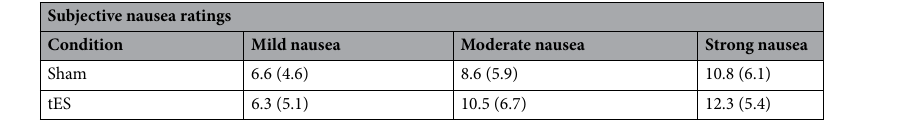
Table 1. Mean ± S.D. subjective nausea intensity ratings in minutes. The durations are given relative to stimulus